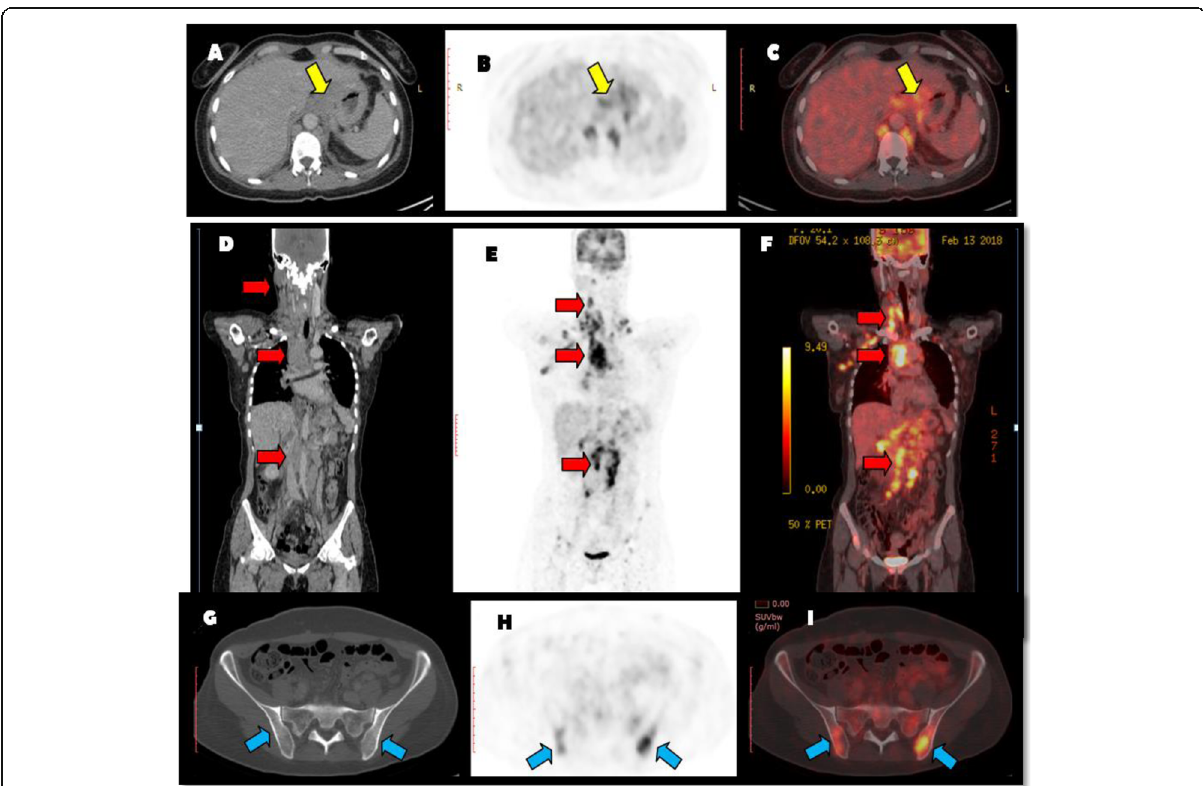
Fig. 6 Axial and coronal post-contrast CT, PET, and PET/CT images for a 42-year-old female patient diagnosed as distal oesophageal and gastric fundus mural thickening by the upper endoscopy and this was pathologically proven to be lymphoma . Images a – c showed an ill-defined metabolically active lower oesophageal, gastro-oesophageal and gastric fundus mural thickening (yellow arrows) with SUVmax= 5.4. Images d – f showed multiple metabolically active supradiaphragmatic and infradiaphragmatic lymphadenopathy (red arrows), the most active lesion is seen in the mediastinal group with SUVmax = 13.8. Images g – i showed metabolically active bilateral iliac bone lesions with no gross corresponding CT findings (blue arrows); their measured SUVmax =